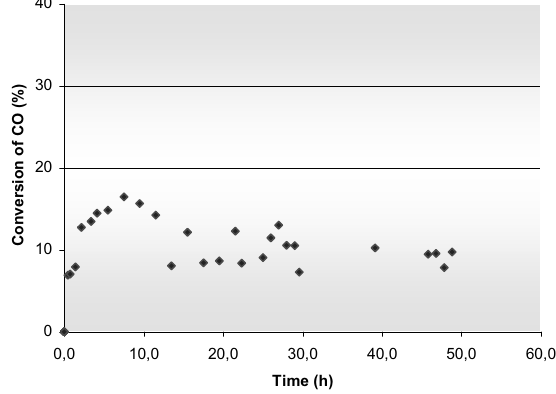
Fig. 5 – Reaction with time on stream for 5% Co-0.6% Pd/Nb 2 O 5